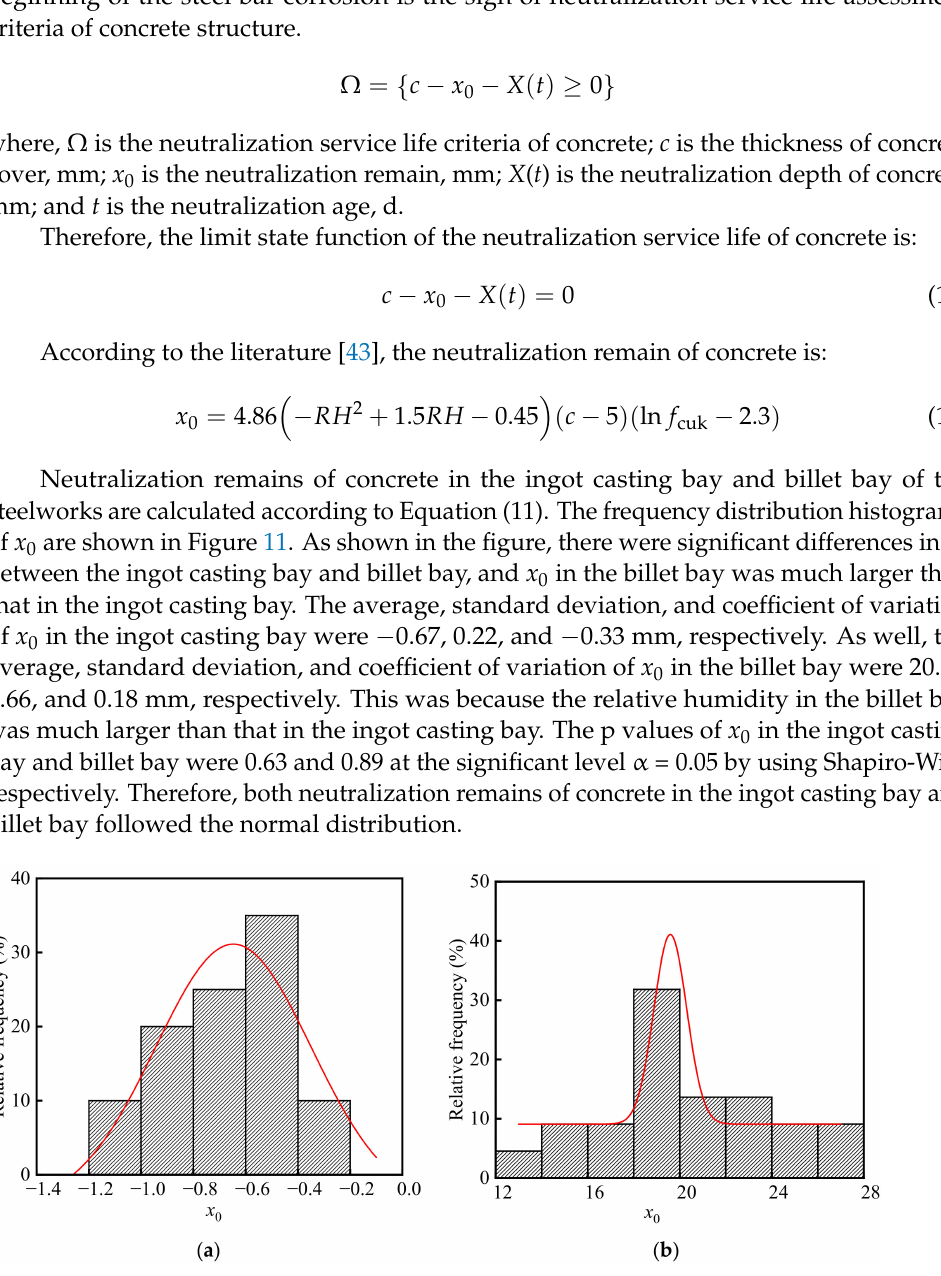
Figure 11. Frequency distribution histograms of x 0 in the steelworks: ( a ) Ingot casting bay; ( b ) Billet